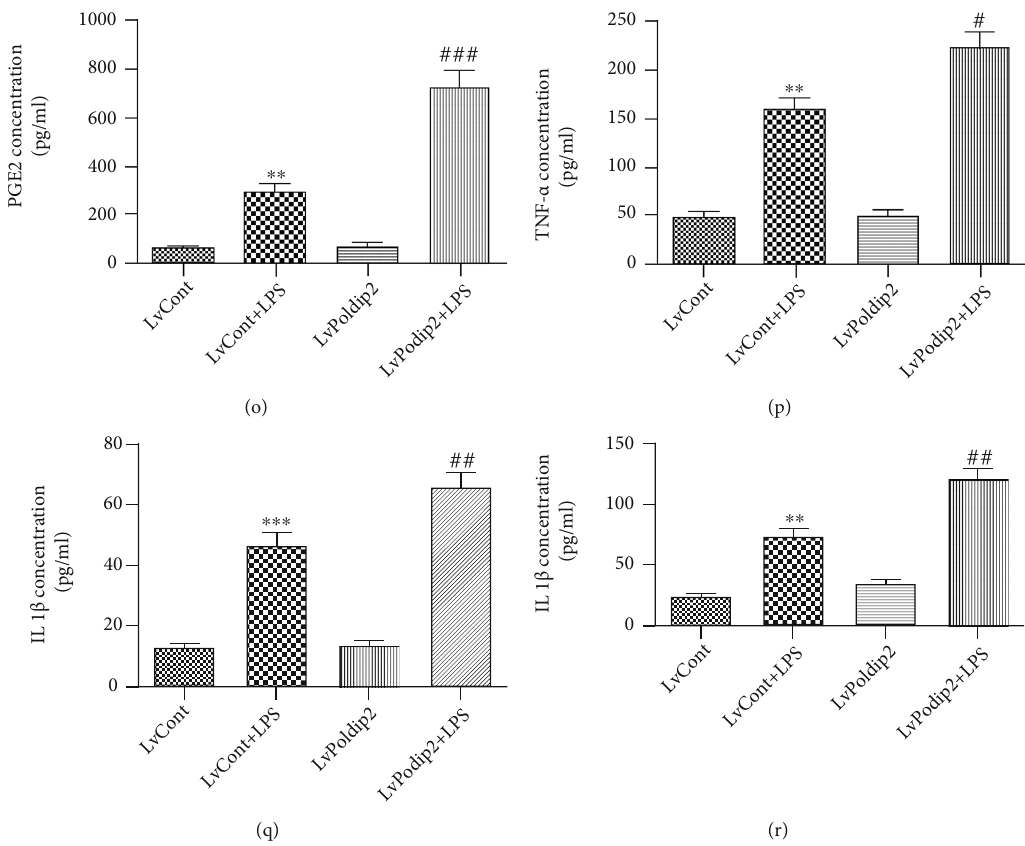
Figure 6: Upregulation of Poldip2 increased LPS-induced oxidative stress and in fl ammation. (a, b) Con fl uent A549 and Beas-2B cells were transfected with the lentivirus upregulation vector for 72h, and the e ffi ciency of Poldip2 upregulation was veri fi ed by Western blotting and quantitatively analyzed. Following transfection, they were treated with LPS (10 μ g/mL for A549 cells and 1 μ g/mL for Beas-2B cells) for 12 h. (c, d) The protein levels of Nox4, HO-1, and COX-2 were detected by Western blotting and quantitatively analyzed. (e – g, i) The expression of Nox4 in the transfected cells was detected by immuno fl uorescence analysis and a laser confocal microscope. The cells were stained with Nox4 (green) and counter stained with DAPI (blue) (magni fi cation of 400x). (h, j) The NADPH enzymatic activity in cells was detected by a spectrophotometer. (k, l) The production of intracellular ROS was detected by fl ow cytometry. (m – r) The expression levels of PGE2, TNF- α , and IL-1 β in the supernatant were detected by ELISA. Bars are mean ± SD of 3 independent experiments. ∗∗∗ P < 0 : 001 vs. LvCont, ∗∗ P < 0 : 01 vs. LvCont, ∗ P < 0 : 05 vs. LvCont, ### P < 0 : 001 vs. LvCont + LPS , ## P < 0 : 01 vs. LvCont + LPS , and # P < 0 : 05 vs. LvCont + LPS